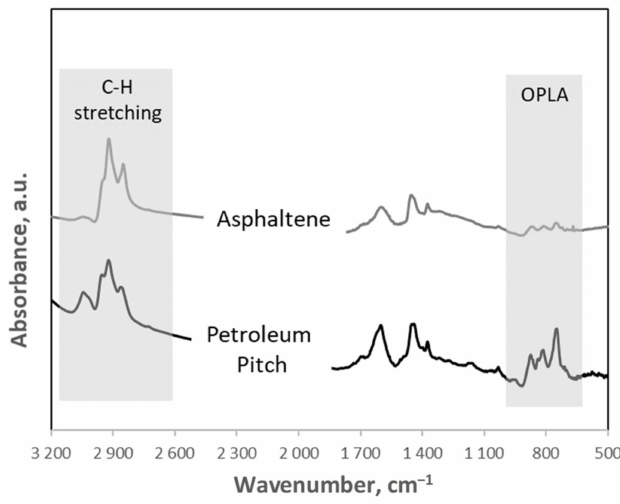
Figure 11. Infrared spectra of a petroleum pitch and an asphaltene